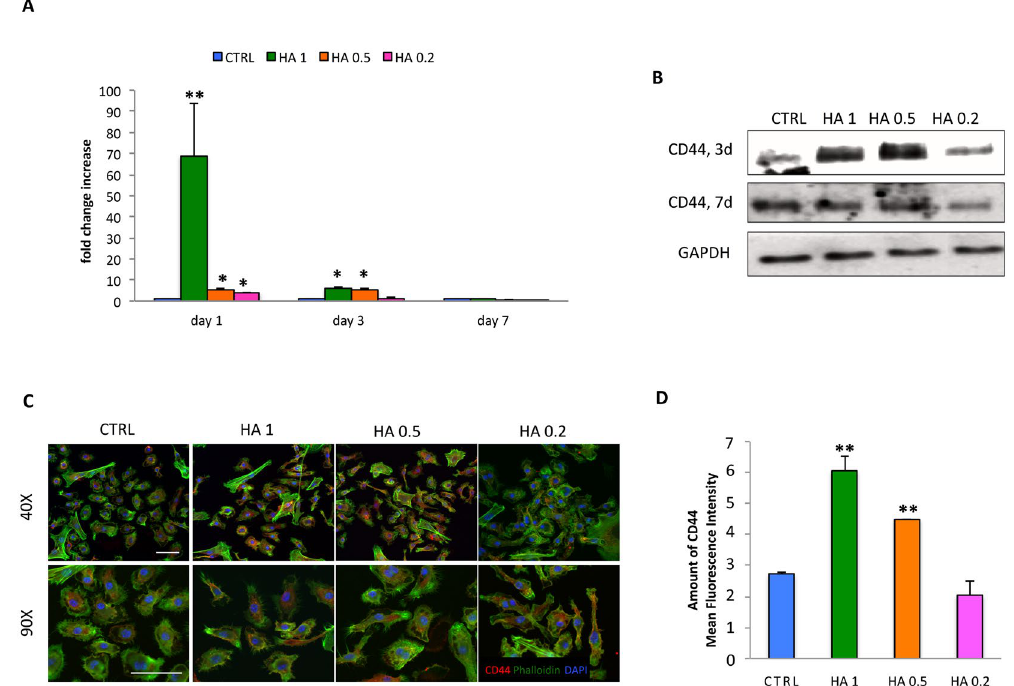
Figure 3. Effect of HA dilutions (0.2–1 mg/ml) on CD44 expression. Comparison between CD44 mRNA levels on MSC grown onto different concentrations HA (HA1, HA 0.5, and HA 0.2) for 1, 3 and 7 days ( A ). Data are represented as fold-change compared with the expression levels found in the untreated cells, CTRL (n = 3; * p < 0.05, ** p < 0.01). Evaluation of CD44 expression on protein extracts from MSC treated with HA (HA 1, HA 0.5, and HA 0.2) or untreated (CTRL) after 3 and 7 days (3d and 7d, respectively). GAPDH was used as loading control ( B ). Immunofluorescence staining of MSC for CD44 (red), DAPI (blue) and Phalloidin (green) following 1-day exposure to HA at different concentrations. 40X and 90X magnifications. Scale bars: 50 μ m ( C ). Quantification of CD44 mean fluorescence intensity on MSC. Asterisks depict significant ( ** p < 0.01) differences between cells exposed to HA (HA 1, HA 0.5, and HA 0.2) and untreated cells (CTRL) ( D